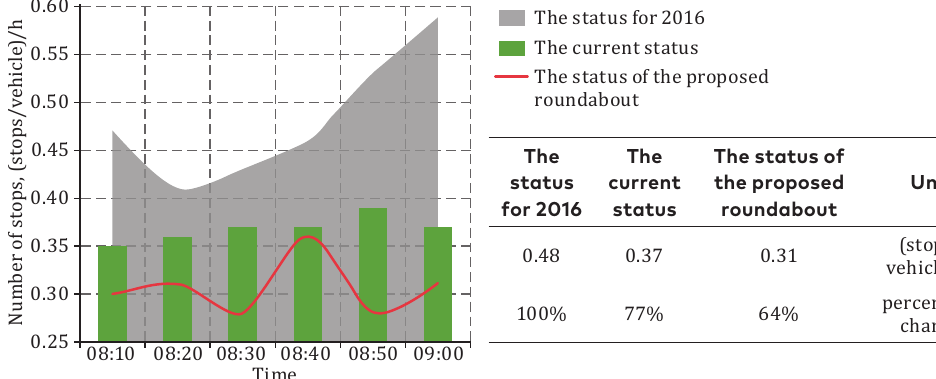
Figure 20. Number of stops-time